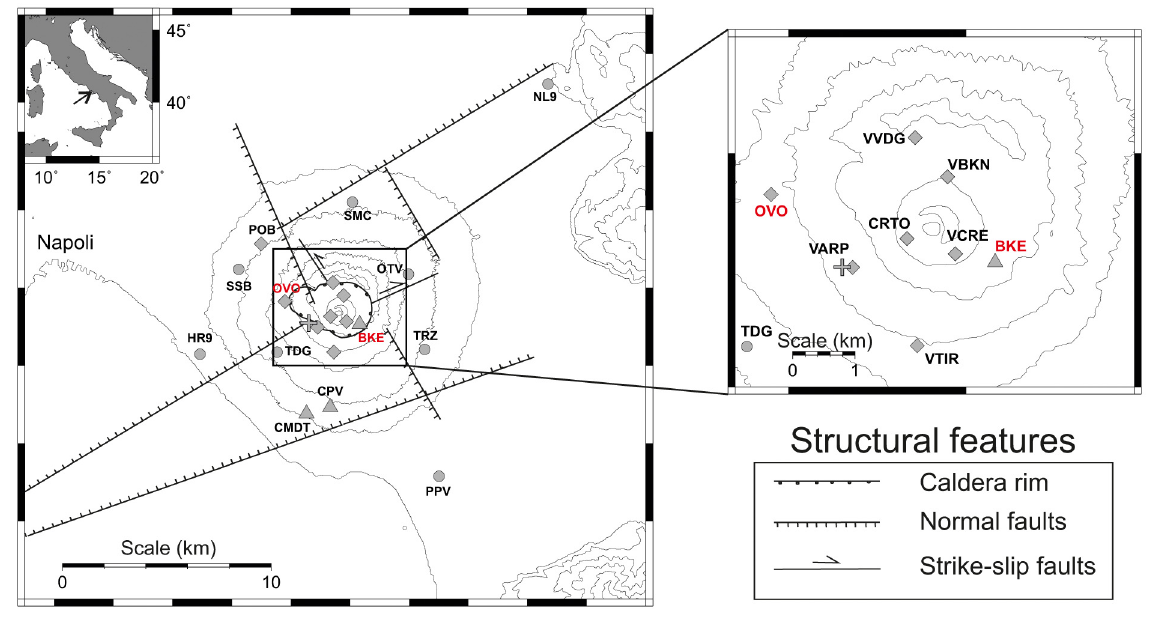
Figure 1. Map of the Vesuvius permanent seismic network. Circles: short-period 1C stations; Triangles: short-period 3C stations; Diamonds, broadband stations. The Vesuvius permanent array is indicated by a cross. Stations BKE and OVO are evidenced in red. Structural features are taken from: Vilardo et al. [1996], Bianco et al. [1998], Orsi et al. [2003].